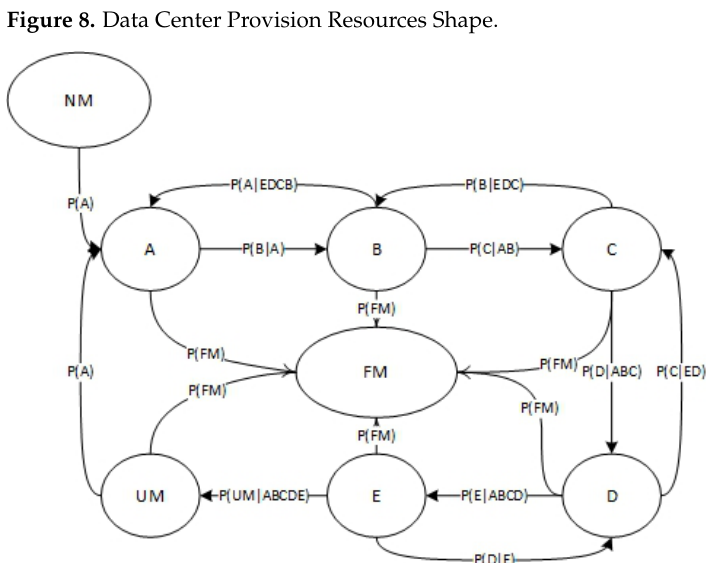
Figure 9. Machine States in a Bayesian